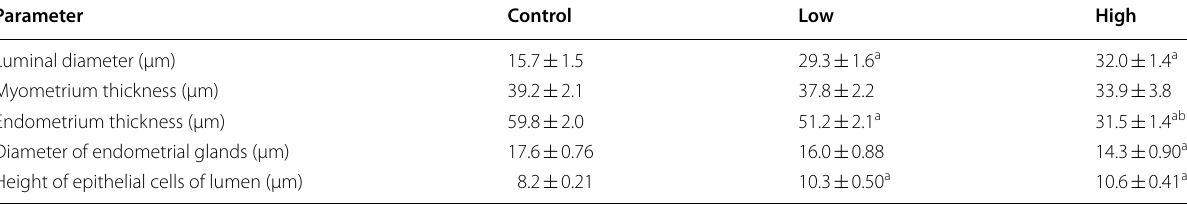
The data are expressed as mean a P < 0.05 as compared with control b